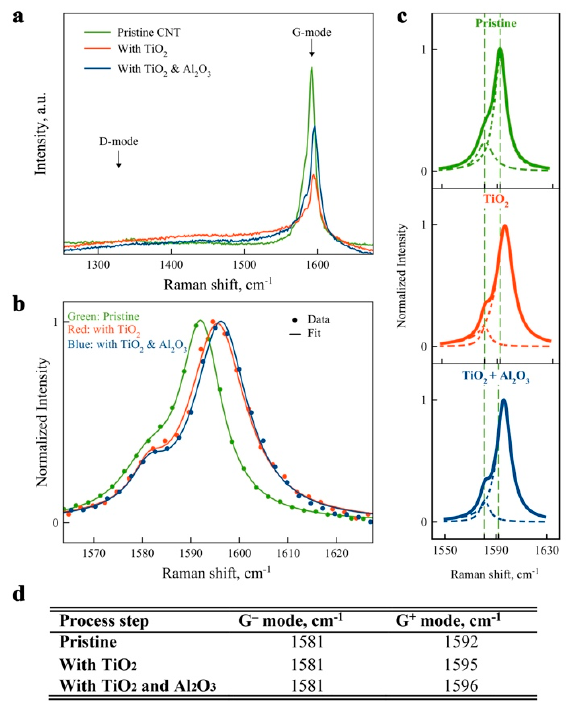
Figure 2. E ff ect of CNT coating analyzed by Raman spectroscopy before and after each deposition step: ( a ) as obtained G and D modes; and ( b ) G-mode region normalized and fitted with two Lorentzian line shapes for G − and G + modes, separately shown in ( c ) for each spectrum; ( d ) A table